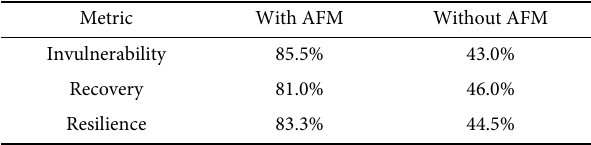
Table 3 Resilience metrics for current contributions